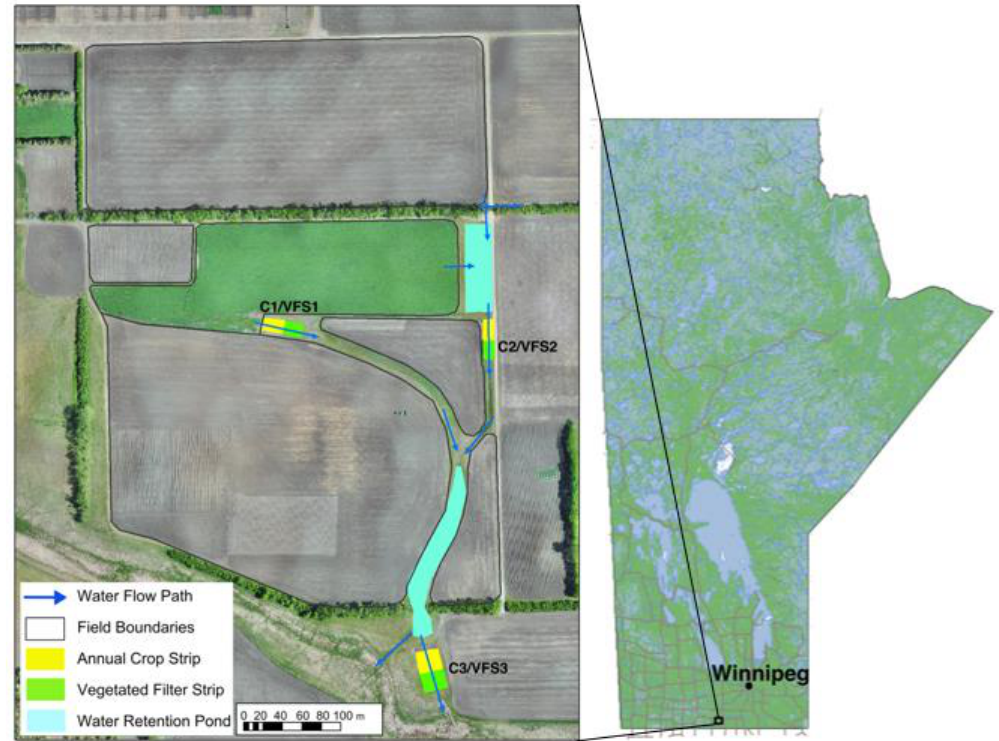
Figure 1. Map of the cropped (control) strips and vegetated filter strips within the 20-ha study area at the Agriculture and Agri-Food Cereal Research Centre in Morden, Manitoba, Canada.